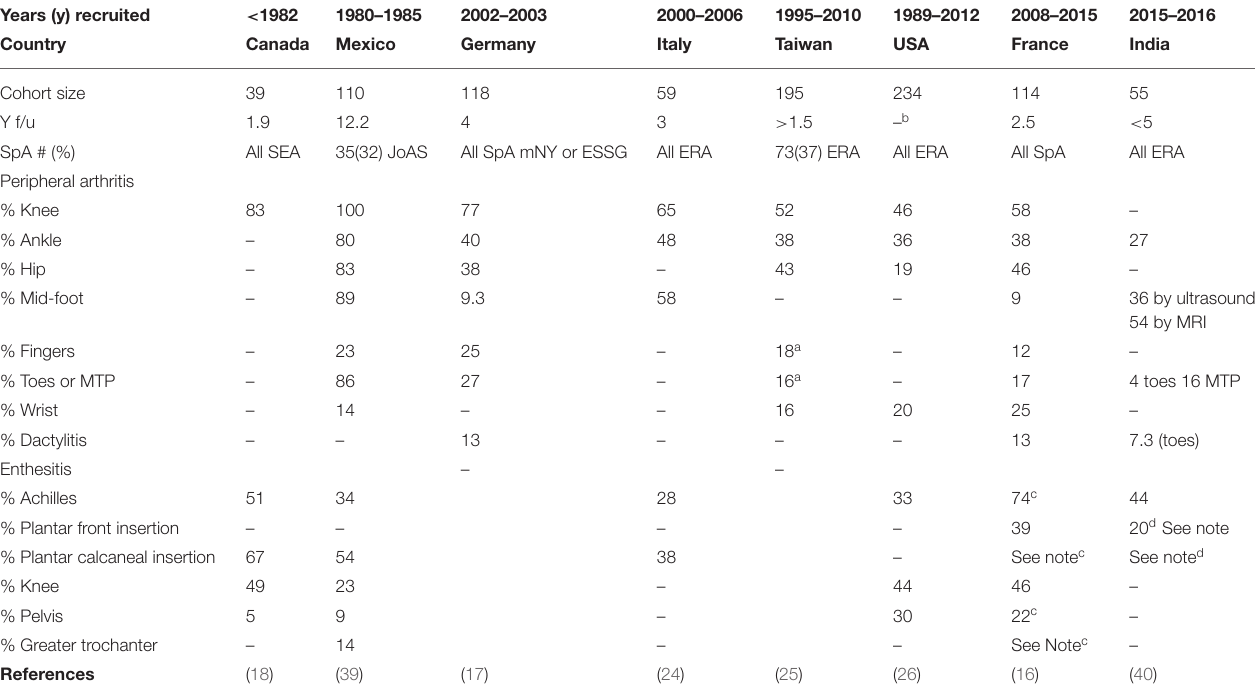
TABLE 2 | Anatomic distribution of peripheral arthritis and enthesitis. Years (y)